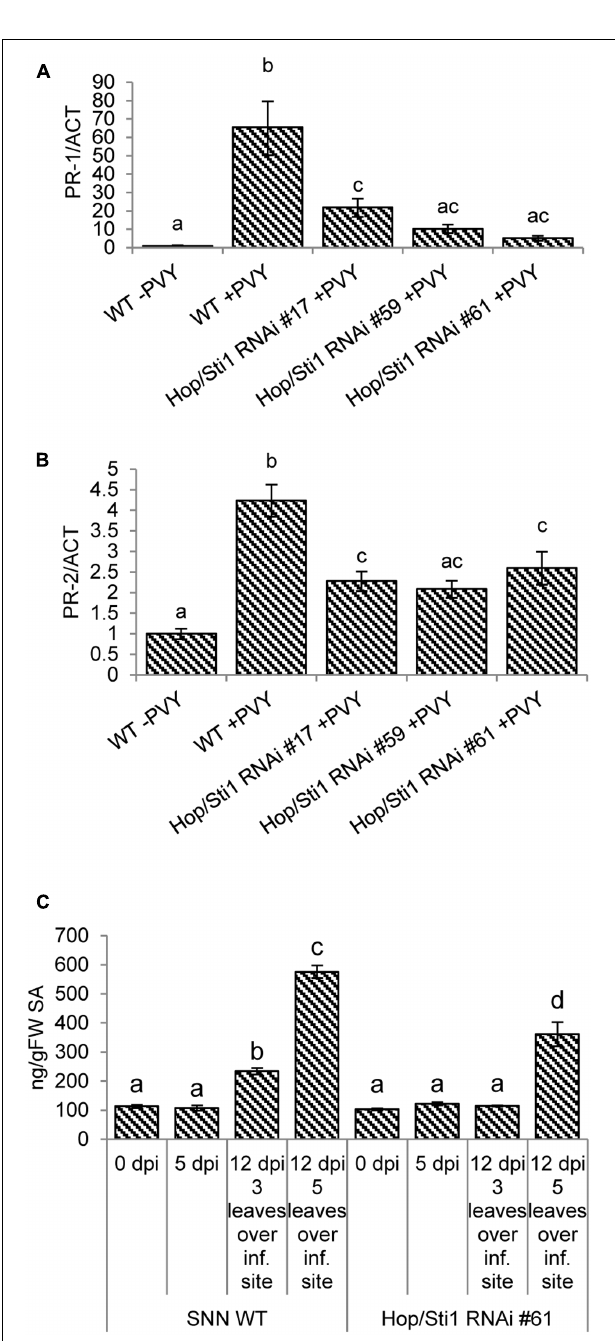
FIGURE 8 | Impaired immune responses after PVY N inoculation in Hop/Sti1-RNAi plants. (A) PR-1 expression was analyzed by quantitative real-time PCR. The expression increased significantly (ANOVA, p -value: 1.2E–05) in samples derived from systemically infected wild-type leaves compared to non-infected samples. PR-1 expression in infected Hop/Sti1-RNAi lines was in all cases significantly (ANOVA, p -values of 3.9E–04, 4.9E–05, 2.2E–05 for lines #17, #59, and #61, respectively) lower than in infected wild-type plants. Error bars represent the standard error. Different letters indicate statistically significant differences (ANOVA, p < 0.05). (B) PR-2 expression was analyzed by quantitative real-time PCR. Infection